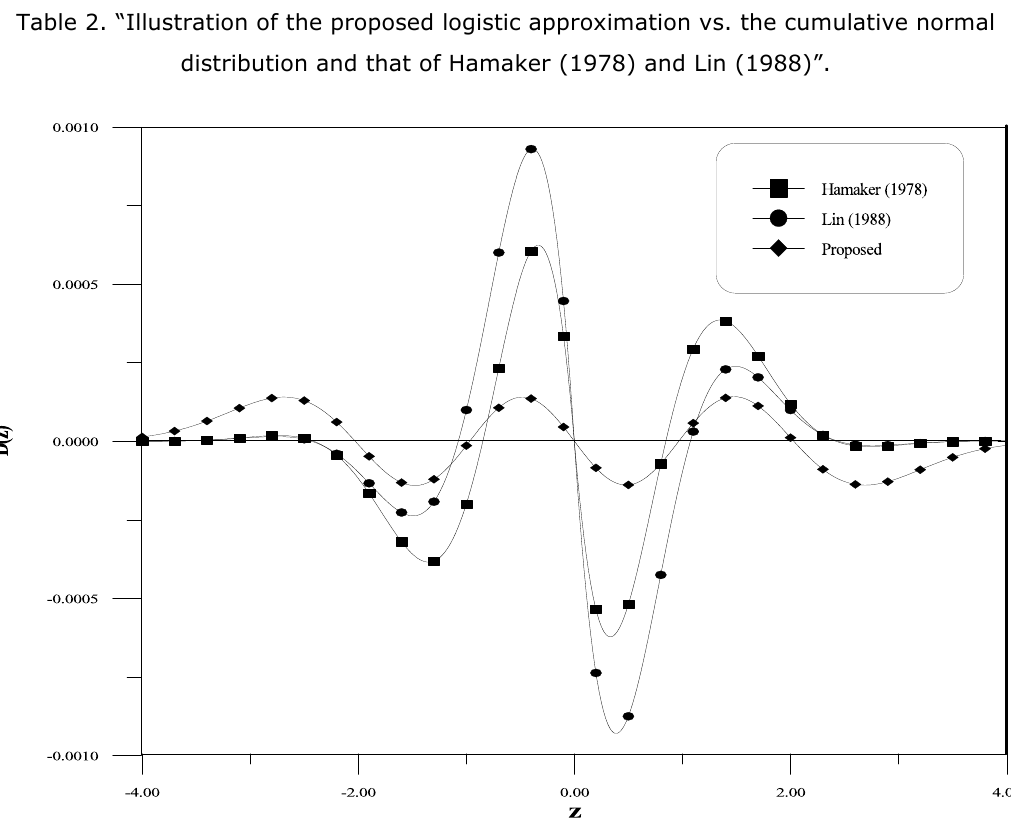
Figure 4. “Graphical illustration of the deviation of the proposed logistic approximation, Hamaker’s (1978), and Lin’s (1988) to the cumulative standard normal